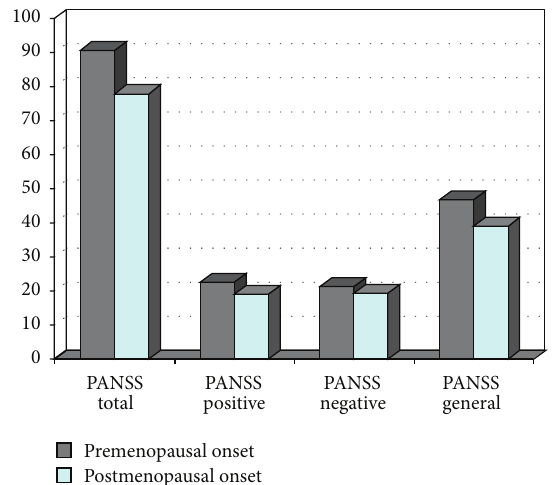
Figure 1: Assessment of psychotic symptoms after 24 months by